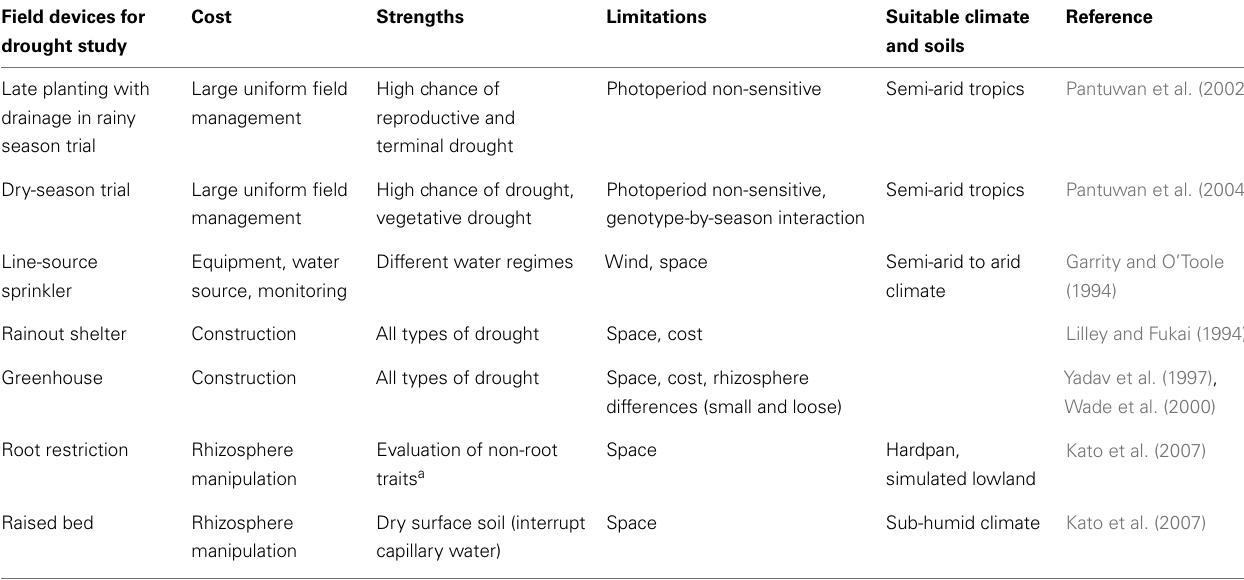
Table 5 | Evaluation of different field devices for genotype study/screening in response to